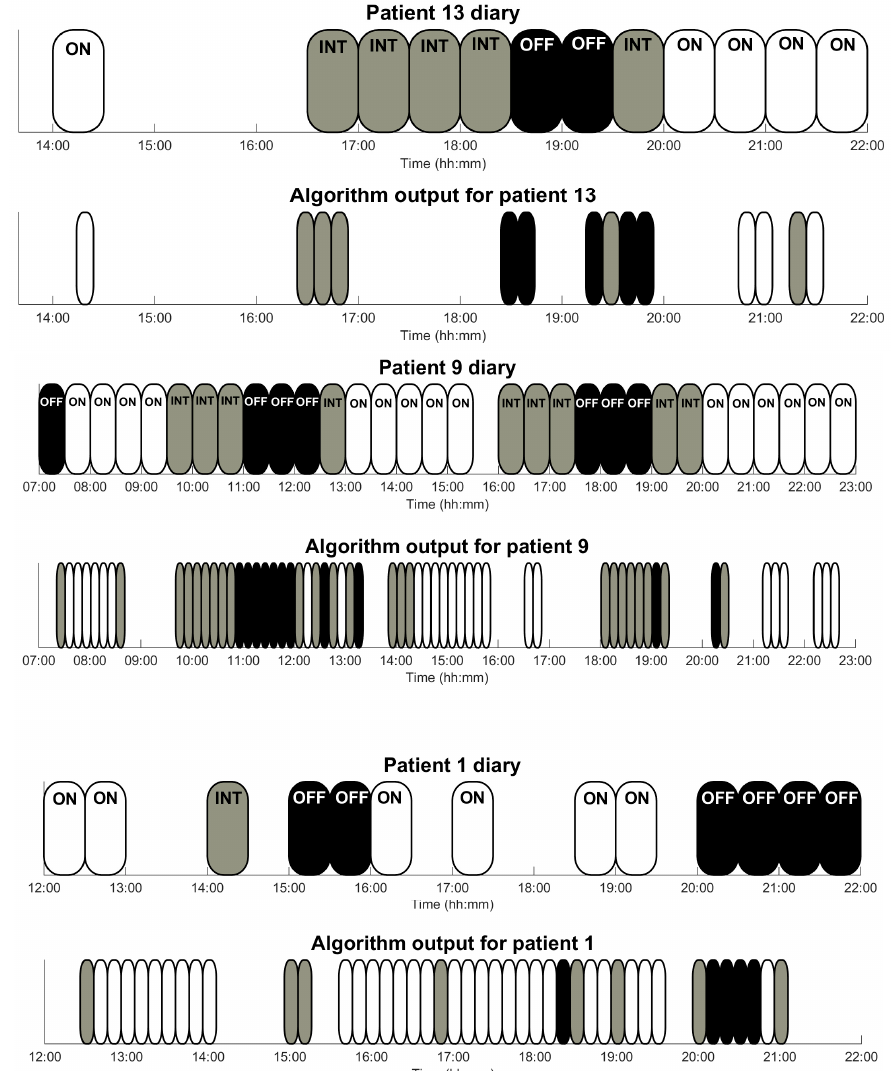
Figure 6. Graphical output of the algorithm for those patients who had the poorest results (patient 1) and some intermediate results (patients 9 and 13) during a day. Patient’s annotations (upper part) cover, each one of them, a time interval 30 min. Sensor outputs comprise 10 min and follow the same code colour: white corresponds to ON-state, grey to intermediate-state, and black to OFF-state.